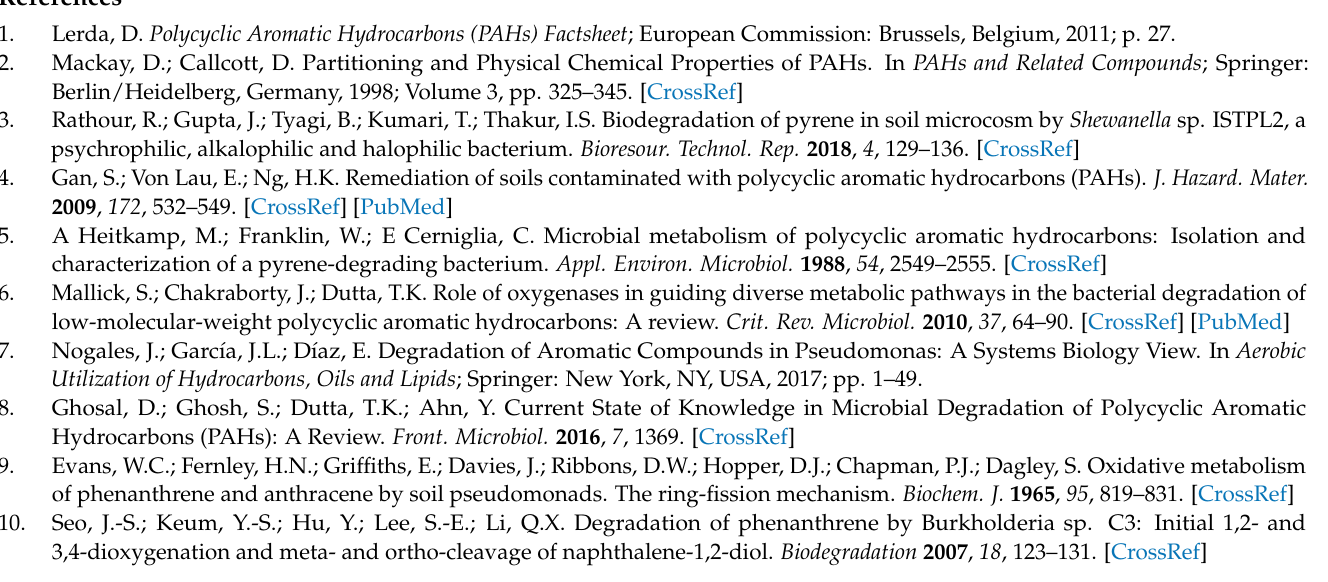
Figure S2: BUSCO result plot of the genome, Figure S3: SCG analysis of the strain D. psychralcaliphila JI1D. Figure S4: the complete genetic machinery present in the process of benzoate degradation obtained from RAST server. Table S1: k-mer results, Table S2: BUSCO assessments data, Table S3: Number of A, T, G, C, N nucleotides present in whole genome sequence, Table S4: Contents of COGs Table S6: legend for Figure